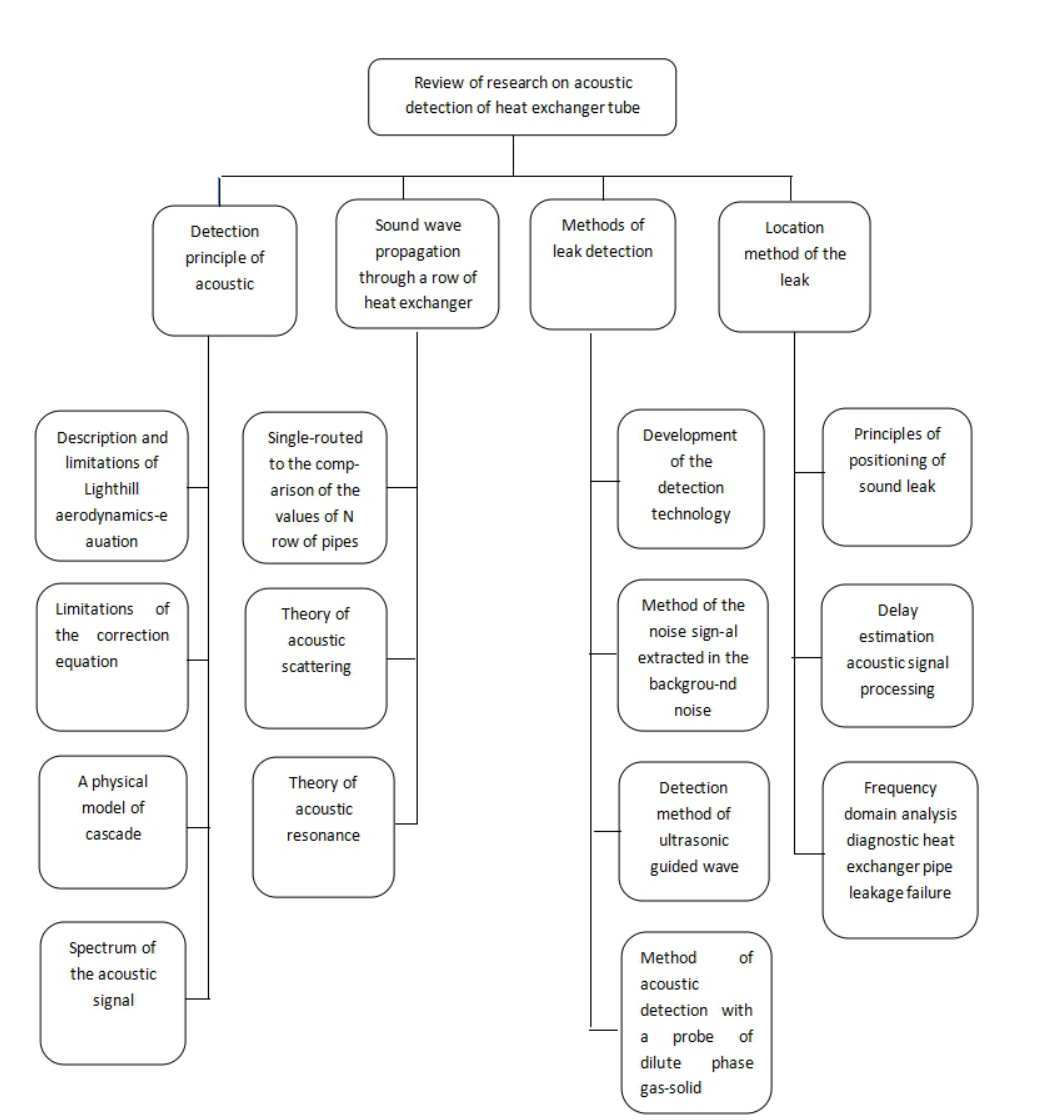
Figure 3. The content structure diagram of this